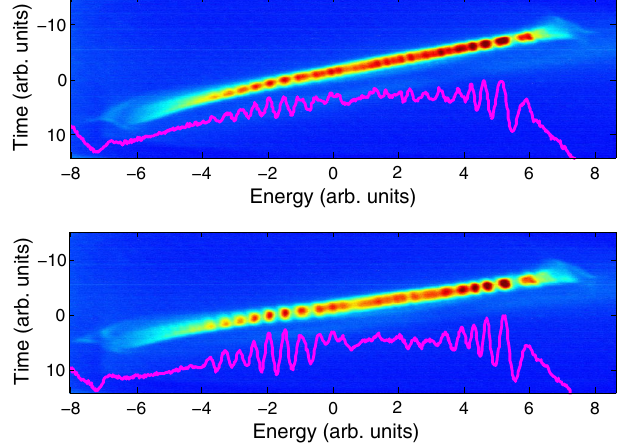
FIG. 63. Examples of phase space fragmentation of compressed electron beams generated from a copper cathode with a flat-top like laser profile obtained with pulse stacking (see Fig. 4). The figures show particle densities of the vertically streaked beam as recorded on a screen in the dispersive section of the high-energy spectrometer for compression factors of 6 (top) and 12 (bottom). The magenta lines are projections of the distributions onto the horizontal (energy) axis, emphasizing the fragmentation effect.